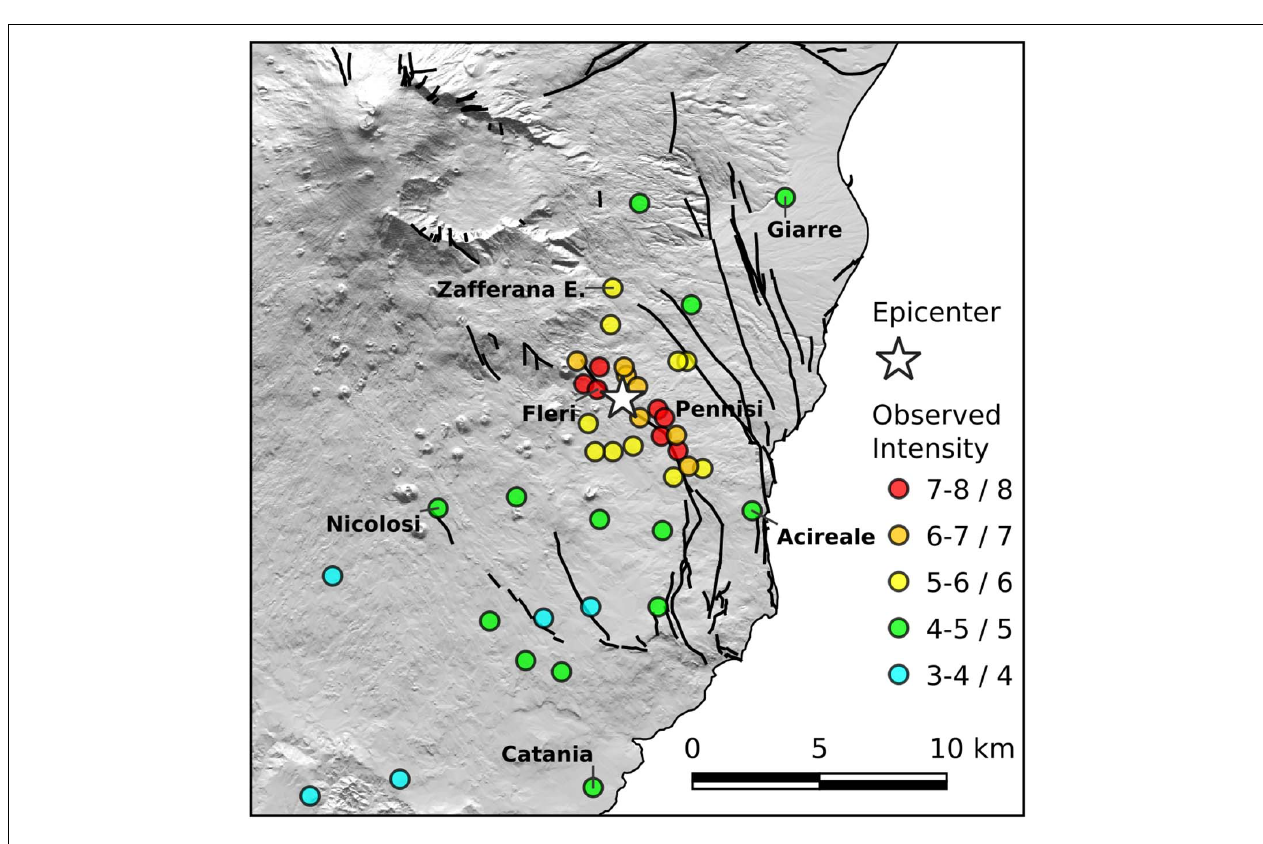
FIGURE 2 | Observed intensity of the December 26, 2018 earthquake (data from Azzaro et al.,